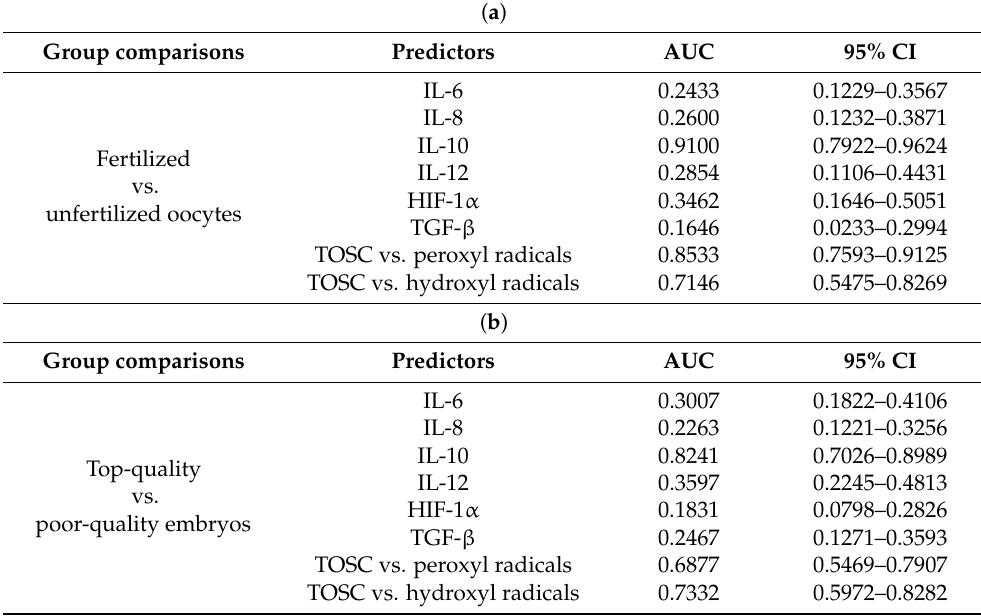
Table 3. Accuracies of each FF biomarker investigated in discriminating fertilized oocytes from unfertilized ones ( a ), and top-quality embryos from poor-quality ones ( b ). The area under the receiver operating characteristic curve (AUC) and its confidence interval (CI) are